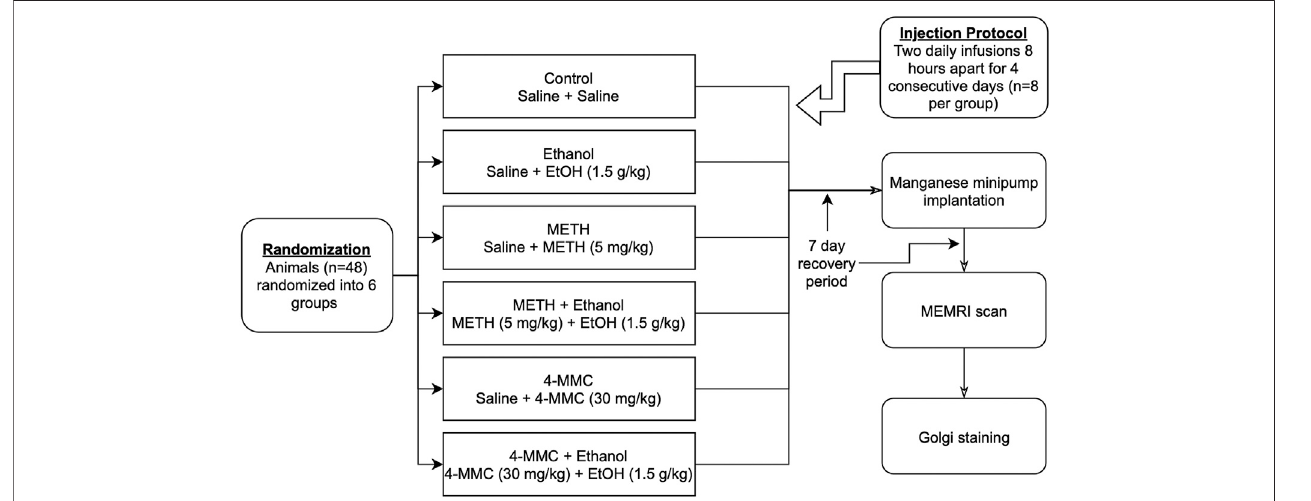
FIGURE 1 | Experimental design shown as a fl owchart. 4-MMC, 4-methylmethcathinone; EtOH, ethanol; METH, methamphetamine.